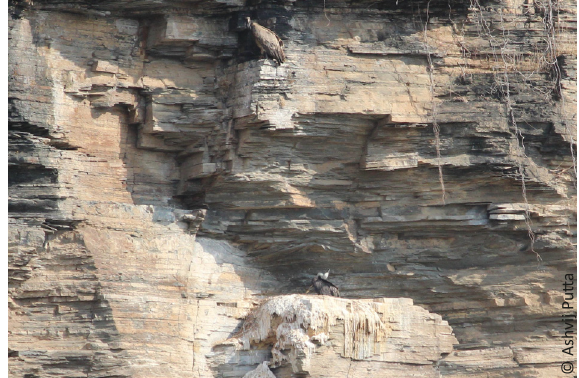
Image 5. Long-billed Vulture nest 3, adult vulture seen feeding the chick on 15 March